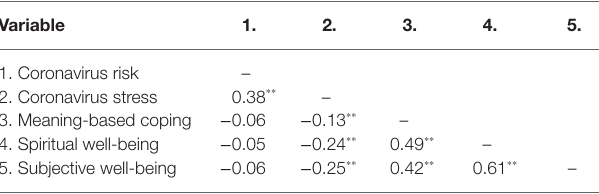
TABLE 2 | Correlations for study